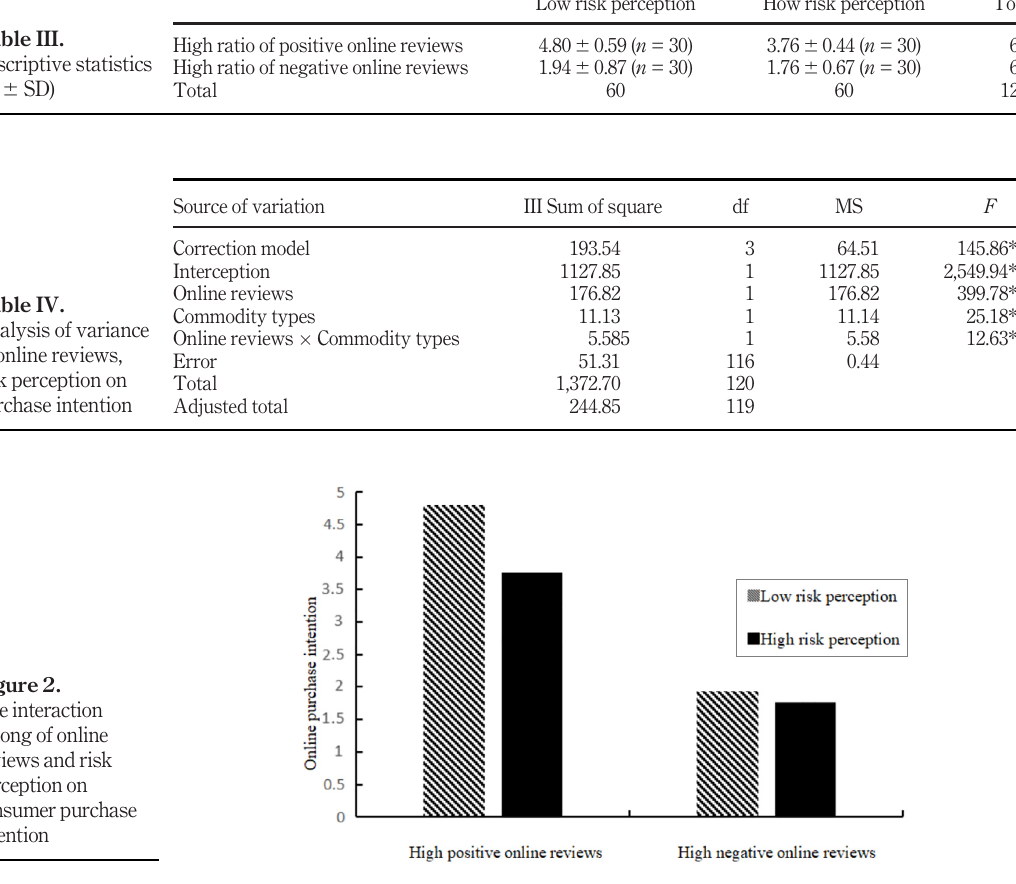
Table III. Descriptive